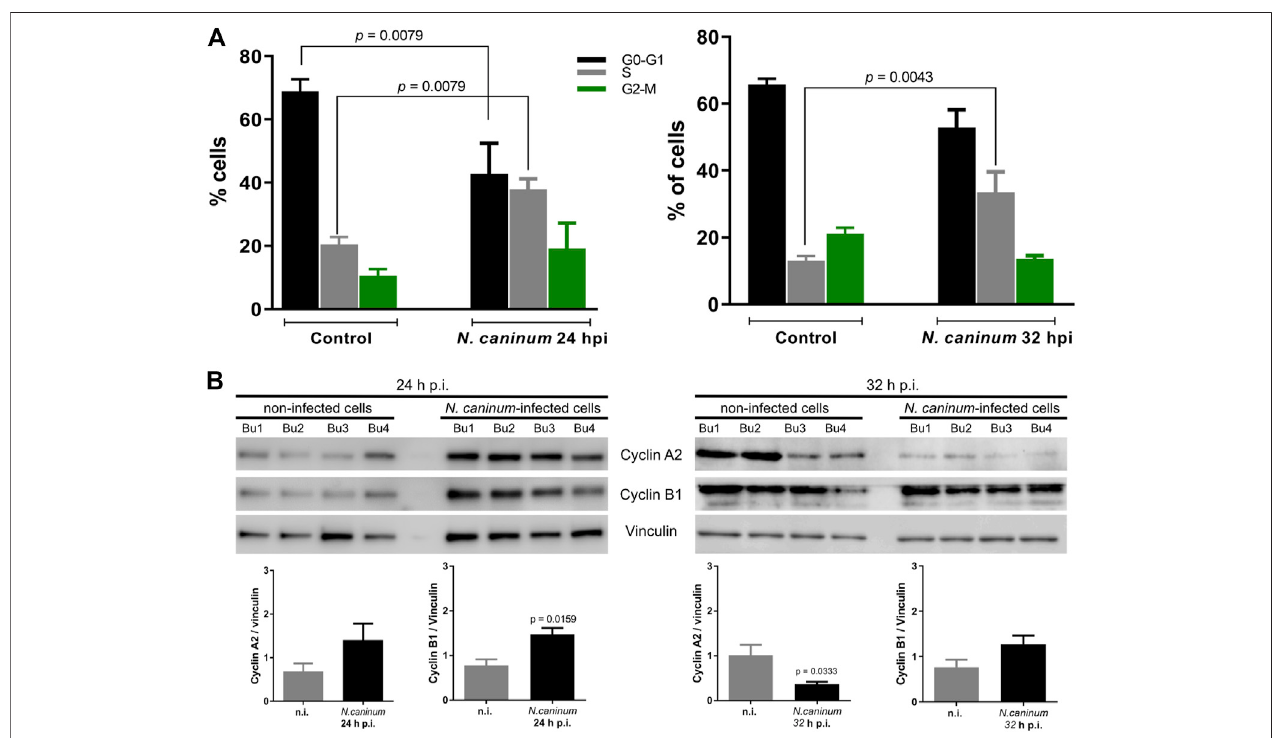
FIGURE 2 | Effects of N. caninum infection on the host cellular cell cycle and on cyclin A2 and B1 abundance. Sub-con fl uent BUVEC ( n = 6) were infected with tachyzoites of N. caninum at an MOI of 3:1 and examined for DNA contents at 24 and 32 h p. i. by FACS-based analyses. (A) Cell population was fi rst gated in order to eliminate debris from the analysis. Furthemore, the DNA channel vs. the population histogram was used to obtain the total number of cells in each peak. Data were plotted as a percentage of total cells vs. DNA amounts found in each G0/G1-, S- and G2/M-phase, respectively. (B) Analysis of cell cycle-related molecule expression in N. caninum -infected BUVEC. Four biological replicates of BUVEC were infected with N. caninum tachyzoites and analyzed by Western blotting for the abundance of the cell cycle-related molecules cyclin A2 (S-, G2-phase transition), and cyclin B1 (M-phase), at 24 and 32 h p. i. The density of protein signals was quanti fi ed and graphed as a relative ratio to vinculin (loading control). Bars represent the median ±SD of four biological replicates.